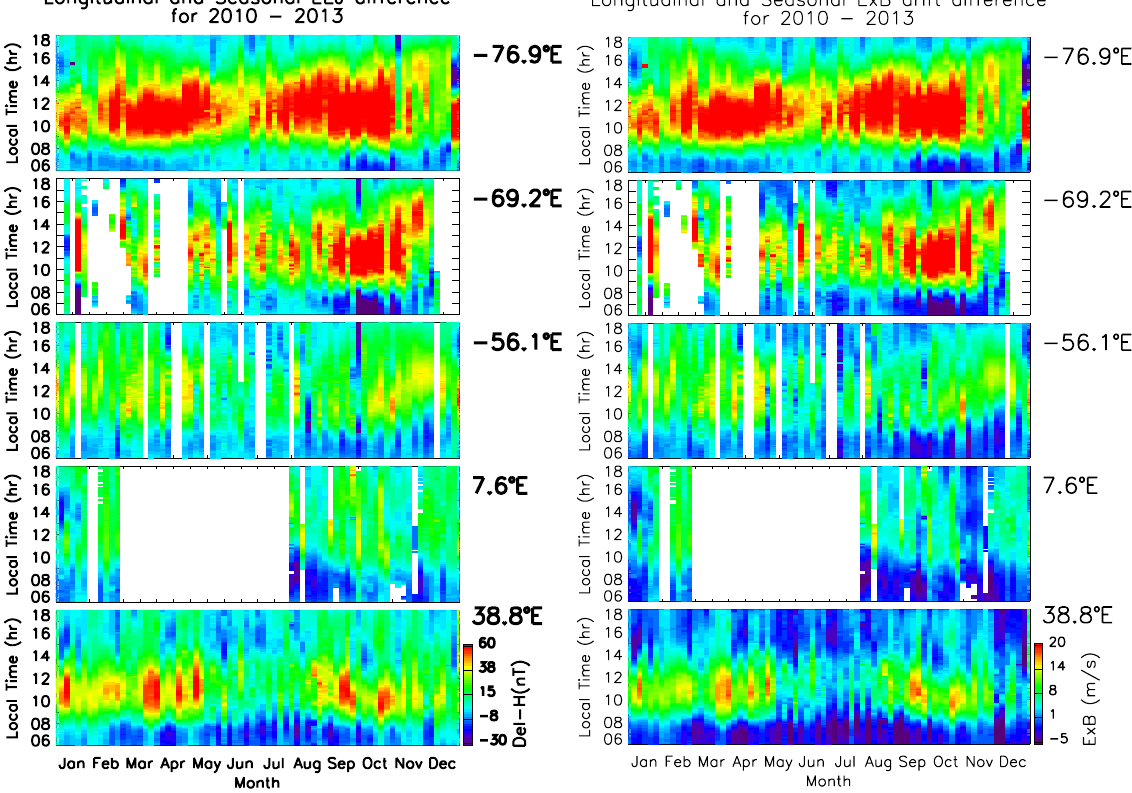
Fig. 4. (Left panel) shows 4-year (2010–2013) average statistical local time as a function of day of the year plots of EEJ, and (left panels) indicates the corresponding vertical drift velocity. From top to bottom, different panels represent different longitudinal sectors which are given at the right side of each